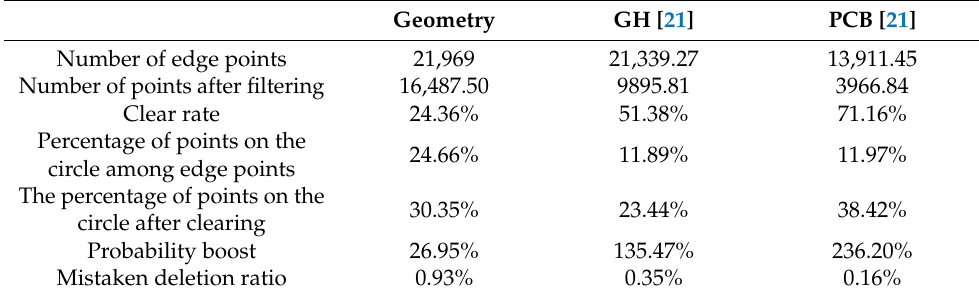
Table 3. The result of useless arc